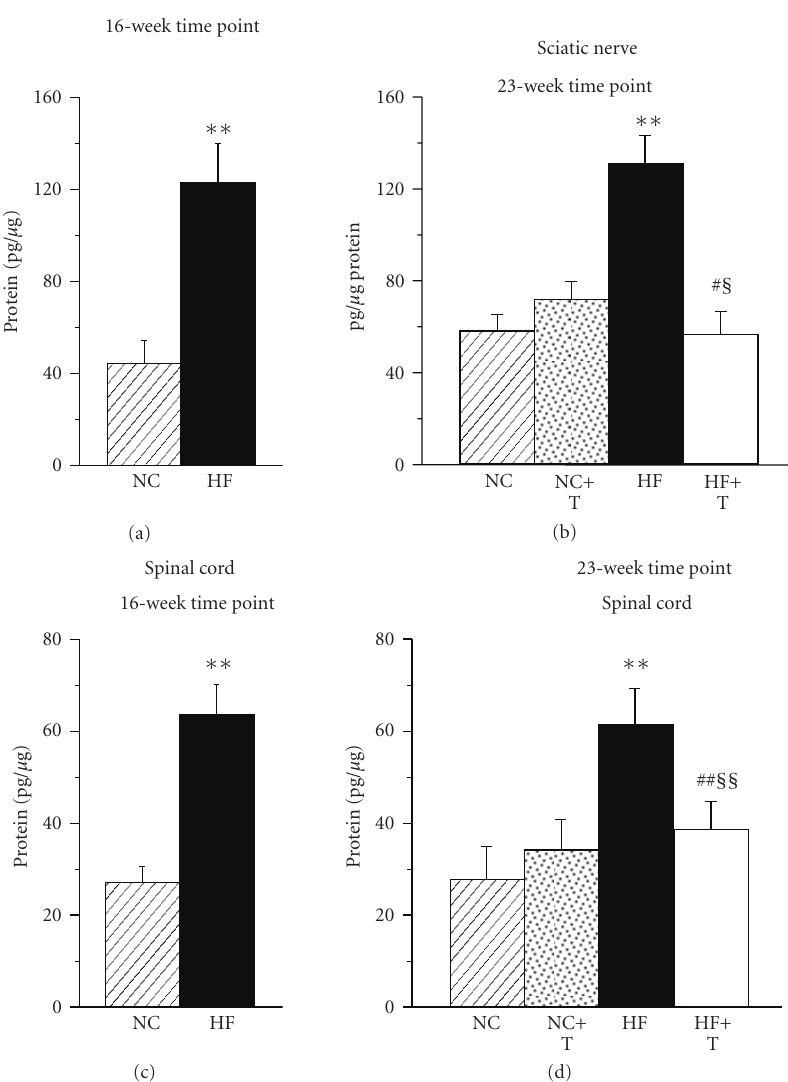
Figure 2: 12(S)-hydroxyeicosatetraenoic acid concentrations in sciatic nerve ((a), (b)) and spinal cord ((c), (d)) after 16-week ((a) and (c)) and 23-week ((b) and (d)) feedings with normal chow or high-fat diet with or without PMI-5011. NC: normal chow, HF: high fat diet, T: treatment. Mean ± SEM, n = 9–13 per group. ∗∗ P < . 01 versus mice fed NC; § , §§ P < . 05 and < . 01 versus the baseline value (16-wk time point); £ P < . 05 versus mice fed NC (16-wk time point); #,## P < . 05 and < . 01 versus untreated mice fed HFD (23-wk time